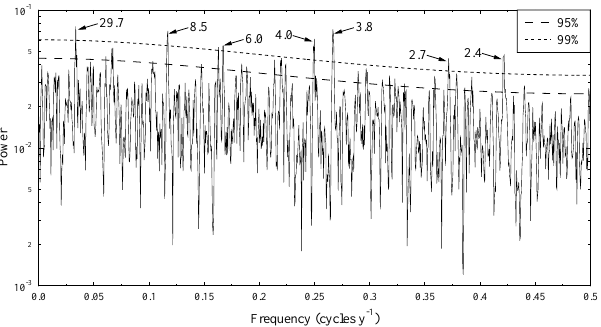
Figure 9. MultiTaper Method power spectrum (Ghil et al., 2002) of power-law-based snow accumulation rate time series using a reso- lution of 2 and 3 tapers. The period of spectral components above 99% significance are shown.